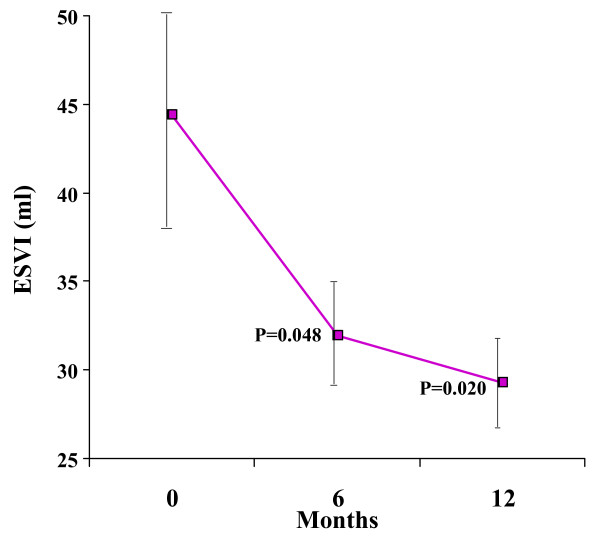
LV end-systolic volume index decreased significantly over 12 months. Standard error bars are shown. The p values shown are post-hoc analyses for 0–6 months, and 0–12 months.